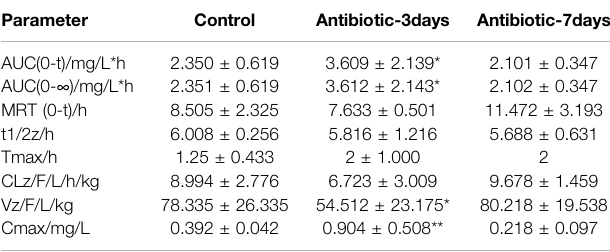
TABLE 3 | Comparison of the pharmacokinetic parameters of Dabigatran (n = 3). Parameter